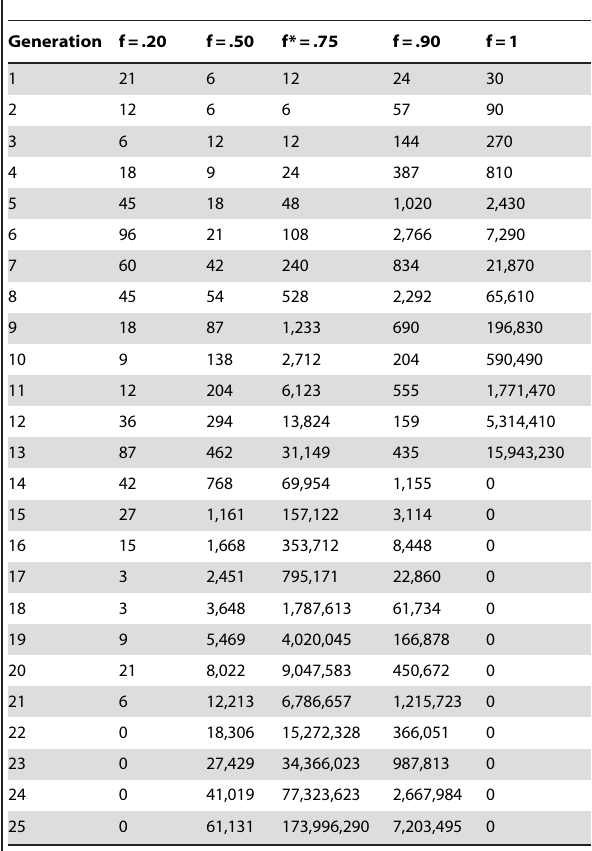
Table 1. Simulated population sizes for binary-choice model with five subpopulations in which individuals choose a with probability f and b with probability 1 { f ,